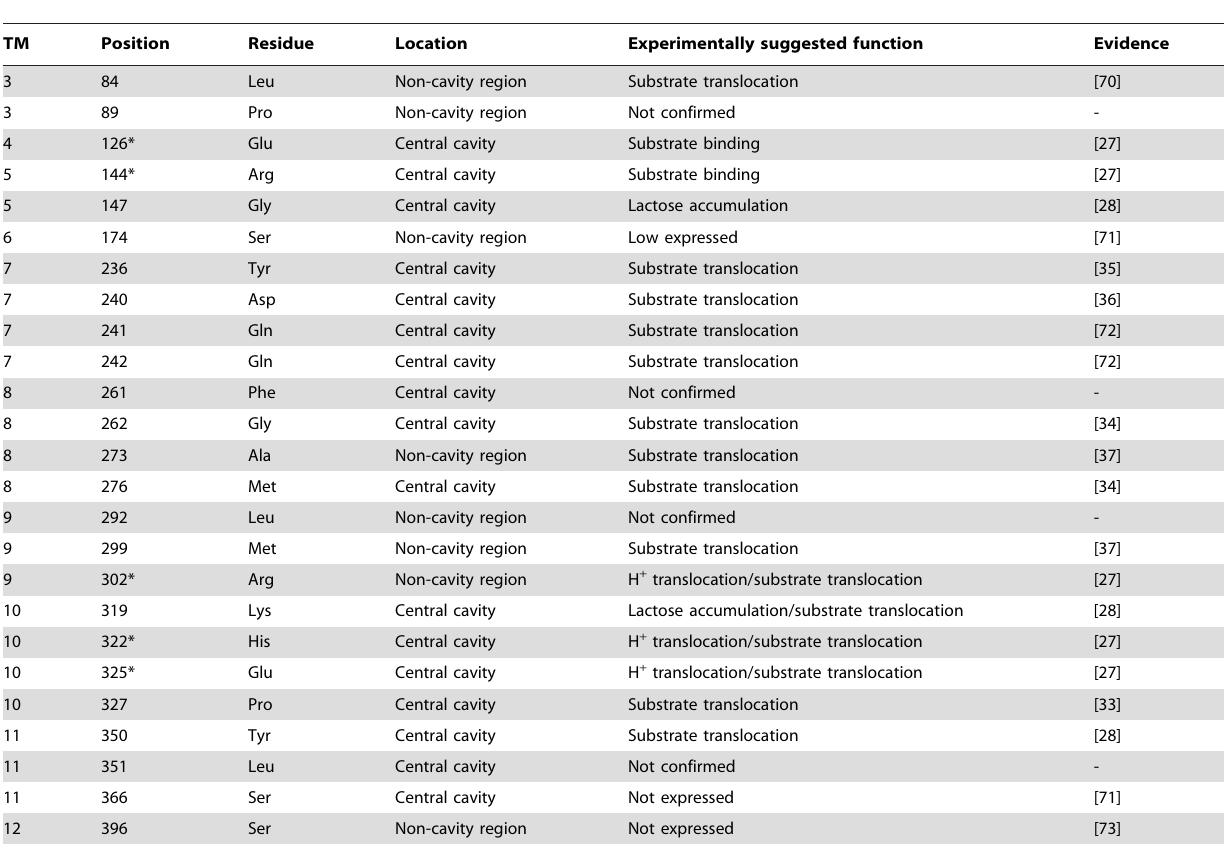
TM represents the transmembrane helix number. * indicates the experimentally confirmed irreplaceable residues for LacY